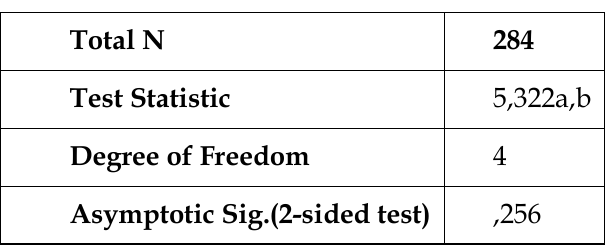
Table 9. Concern about breaching privacy and occupation. Independent Samples Kruskal-Wallis sig. test. The test statistic is adjusted for ties.